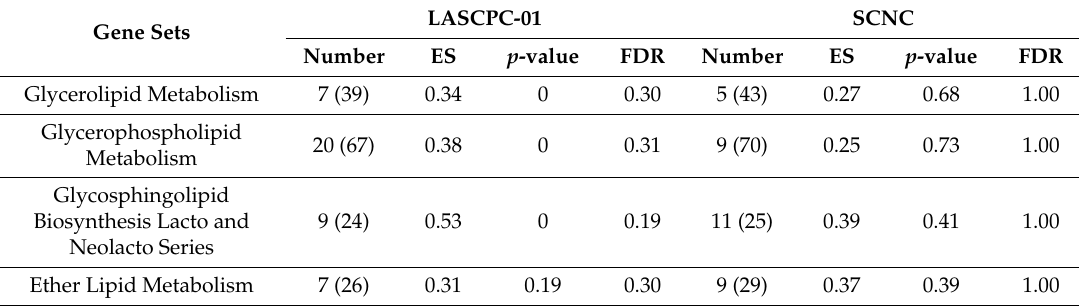
Table 3. Upregulated gene sets in lipid metabolism in the LASCPC-01 cell line and SCNC patients.